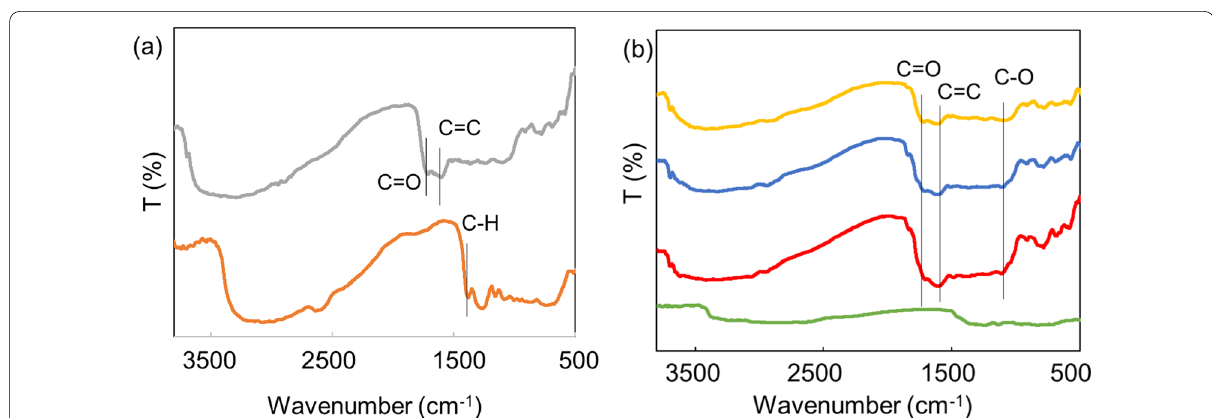
Fig. 3 FT-IR spectrum of ( a ) ball-milled single raw biomass cherry tree leaves (BM) and ball-milled raw biomass cherry tree leaves and humic acid (HBM) (orange line: BM and gray line: HBM) and ( b ) as-prepared biochar (green line: carbonization of BM at 400 °C (BM-400); red line: carbonization of HBM at 400 °C (HBM-400); blue line: carbonization of HBM at 300 °C (HBM-300) and yellow line: carbonization of HBM at 200 °C